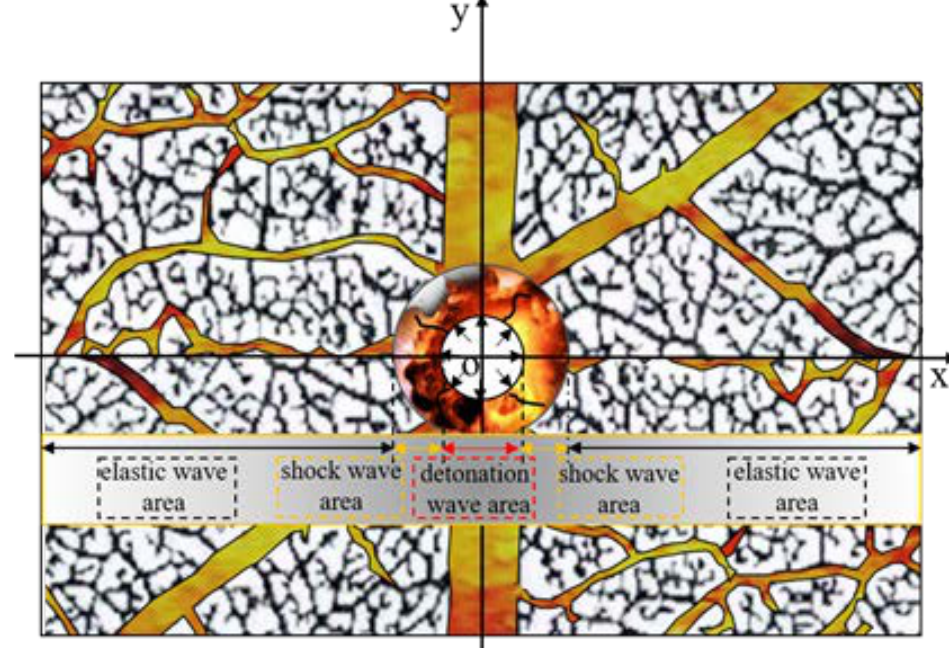
Figure 1. Diagram of fracture propagation caused by combustion-explosion in shale reservoir. How these anomalous shale structures and properties under the conditions of combustion–explosion affect wave propagation is still unclear. Theoretical and numer- ical simulation studies have been carried out for wave propagation in different materi- als [12,13]. However, unlike previous studies, one important task for wave propagation in the process of combustion–explosion is to establish a mathematical model along the real path [14–17]. The model should well consider the heterogeneous pores and tortuous fractures in the real stratigraphic structure of the shale reservoir, especially overlaying the effect of combustion–explosion. Fractal geometry can describe the fine structure of a porous shale reservoir. The theory of local fractional derivatives has also been successfully applied to many problems in fluid mechanics [18] and others [19,20]. And the fractal traveling-wave transformation was introduced to solve the local fractional models [21]. Some wave equa- tions have been proposed so far, such as simple wave equations on the cantor sets, local damped wave equations, and local fractional diffusion wave equations [15,16]. However, as in-situ combustion–explosion is an original technique, the wave propagation model under this condition has not been established and analyzed yet. This paper is organized as follows. First, two novel local fractional wave propagation models are proposed by replacing the derivatives of an integer order with fractional order based on classical wave equations. The models describe the rotation angle from the detonation wave stage to the shock wave stage and the P-wave displacement at the elastic wave stage, respectively. Second, the two models are solved through the separation of variables method and variational iteration method, respectively. The fractal analytical solutions for rotation angle and P-wave displacement are obtained, respectively. Then, the impacts of the branching parameter of the detonation wave converge bifurcation